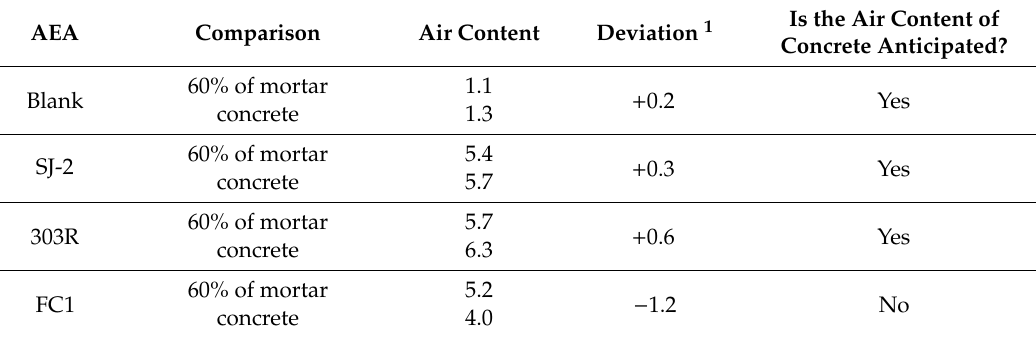
Table 7. Air contents of concrete prepared in low atmospheric pressure (in Lhasa),